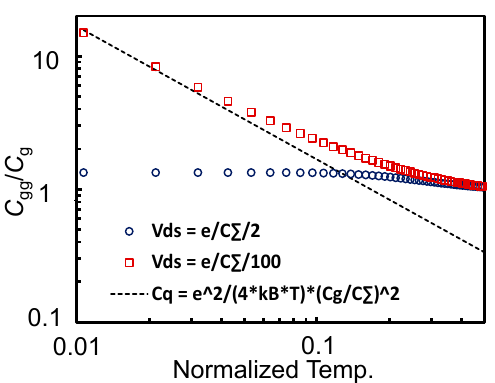
Figure 6. SET input capacitance C gg as a function of temperature at drain voltages V ds = 0.534 mV [0.01] and 26.7 mV [0.5], and gate voltages V gs = 80.1 mV [0.5] and 93.5 mV [0.6], respectively.